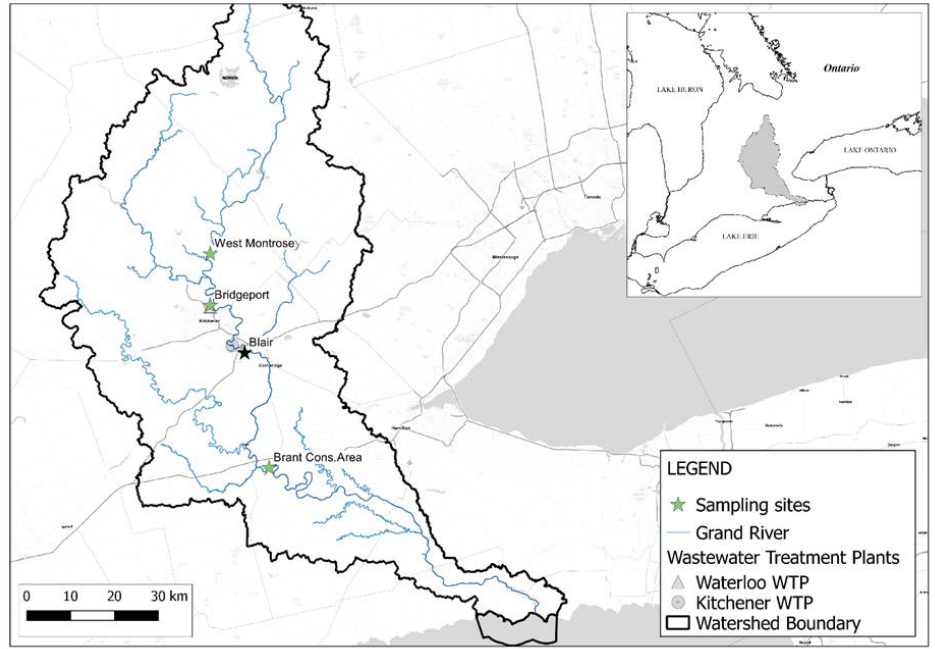
Figure 1. Study sites in the central Grand River. Sampling locations West Montrose and Bridgeport represent upstream of the most populated urban area; Blair located within the urban area, 5.7 km downstream of the Kitchener Wastewater Treatment Plant effluent discharge. Brant Conservation Area represents the southern section of the case study.